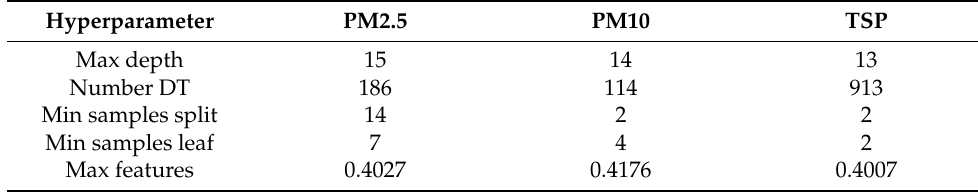
Table 2. Hyperparameters of the random